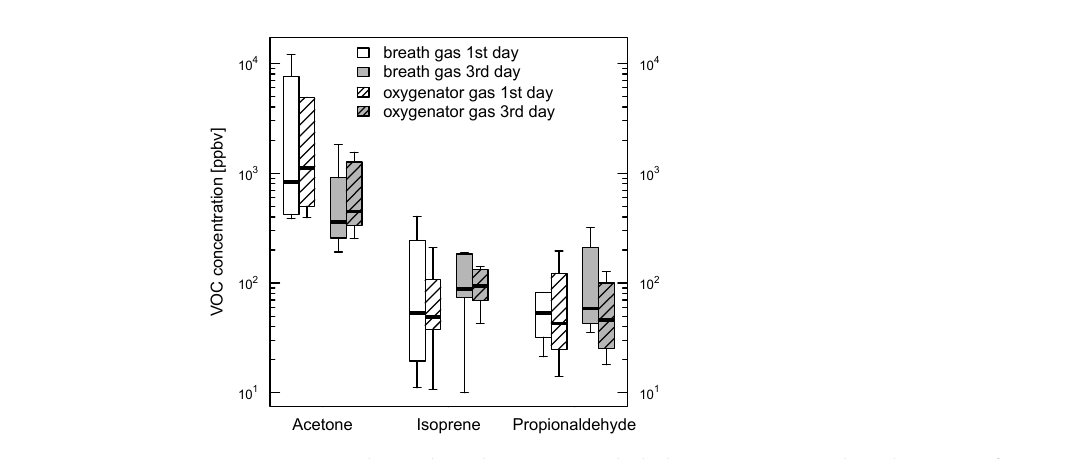
Figure 3. Time-dependent decrease in exhaled VOCs. Temporal evolvement of acetone, isoprene, and propionaldehyde in exhaled breath and oxygenator outflow gas. Note that volatile organic compounds (VOCs) measured in oxygenator outflow gas course are nearly parallel to the values in exhaled breath.